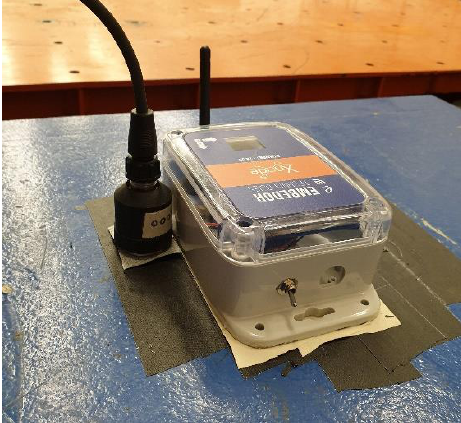
Figure 10. Ambient vibration test setup in the lab.